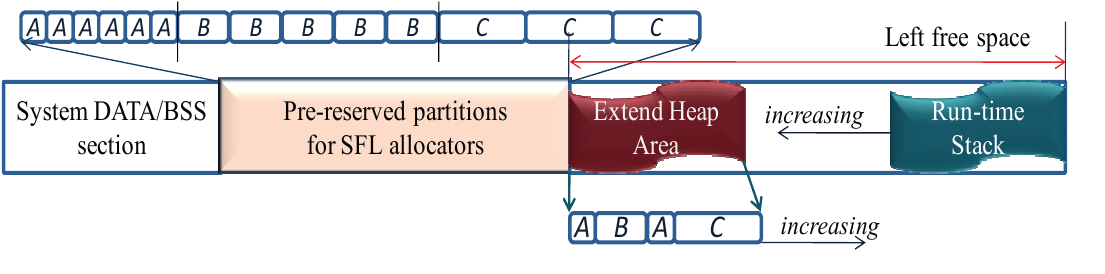
Figure 7. Heap-extendable segregated free list (SFL) allocation in the MIROS. After the partitions are pre-reserved, the left memory space will be utilized both for the extended heap and the run-time